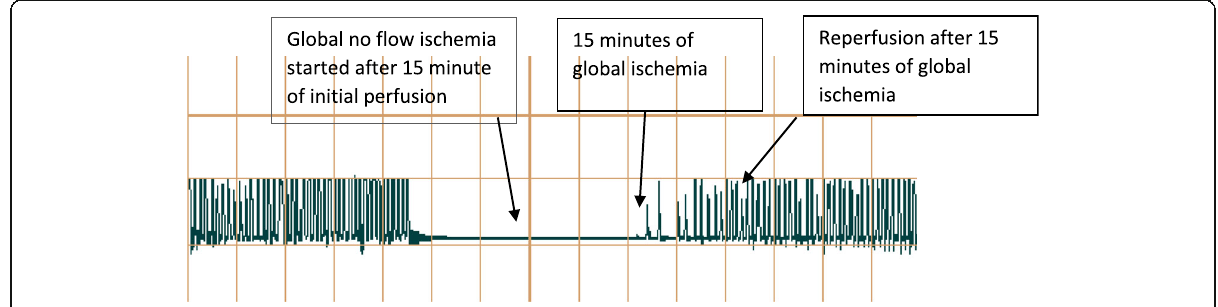
Fig. 11 Tracing on Polygraph of STV-200 +